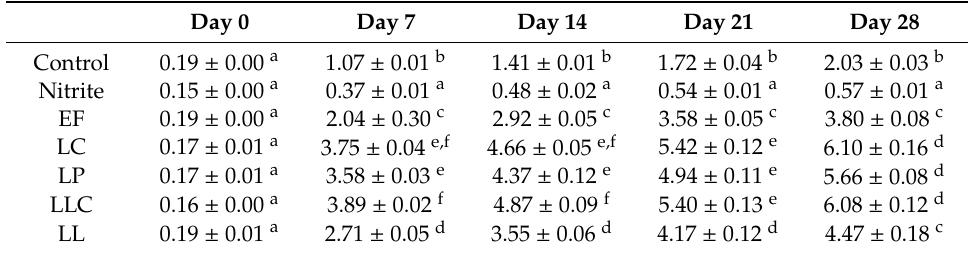
Table 1. Changes in the zinc protoporphyrin IX (ZnPP) content (nmol / g dry matter (DM)) during the production of nitrite-free dry-cured fermented